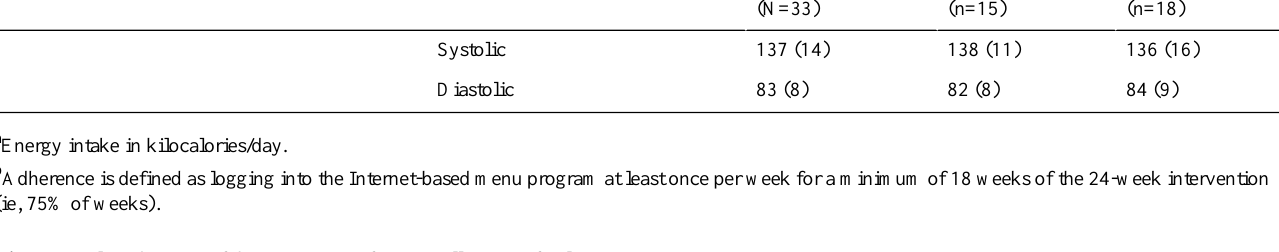
Figure 1. Flow diagram of the participants from enrollment to final